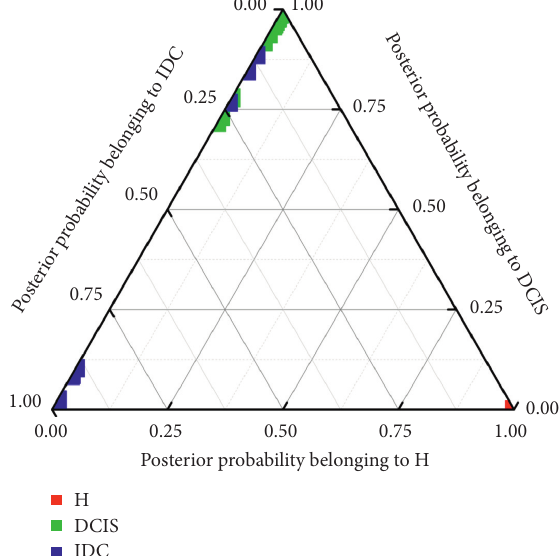
Figure 6: A two-dimensional ternary plot of the posterior prob- abilities belonging to the investigated H, DCIS, and IDC samples calculated from the acquired dataset consisting of all the collected spectra from three tissue types, using the PCA-LDA discriminant model combined with LOOCV